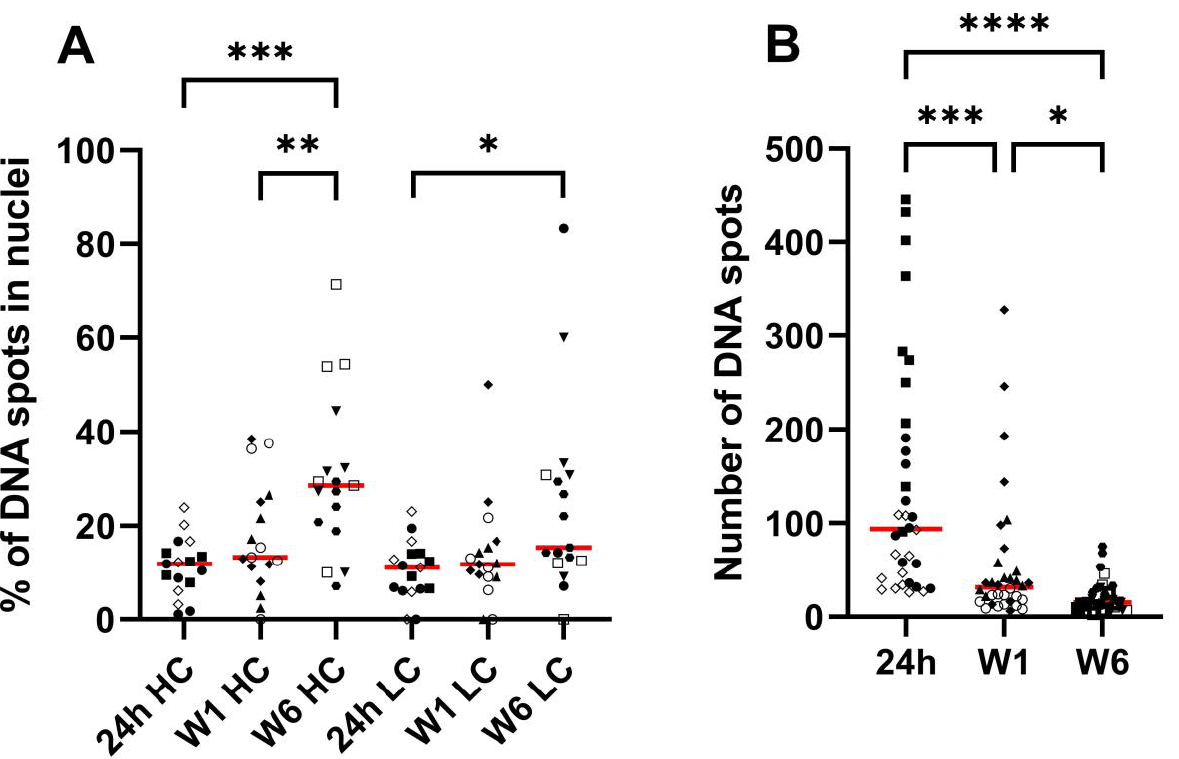
Figure 5. DNA scope pDNA localization and total spot count. Balb/c mice received intramuscular pDNA electrotransfer of 60 µ g pDNA (equimolar mixture pCAG-4D5-HC and pCAG-4D5-LC) in the tibialis anterior muscle. ( A ) DNA scope nuclear pDNA, data points indicate the percentage of DNA dots in nuclei in a single tissue slice, data points from tissue slices originating from the same muscle are indicated with the same symbol (3 animals per time point). ( B ) DNA scope DNA spot numbers, data points indicate the amount of DNA spots in a single tissue slice, data points from tissue slices originating from the same muscle are indicated with the same symbol (3 animals per time point). The red lines represent the median per subgroup (( A ): n = 17, ( B ): n = 34). Asterisks represent the level of statistical significance: * p ≤ 0.05, ** p ≤ 0.01, *** p ≤ 0.001, **** p ≤ 0.0001.